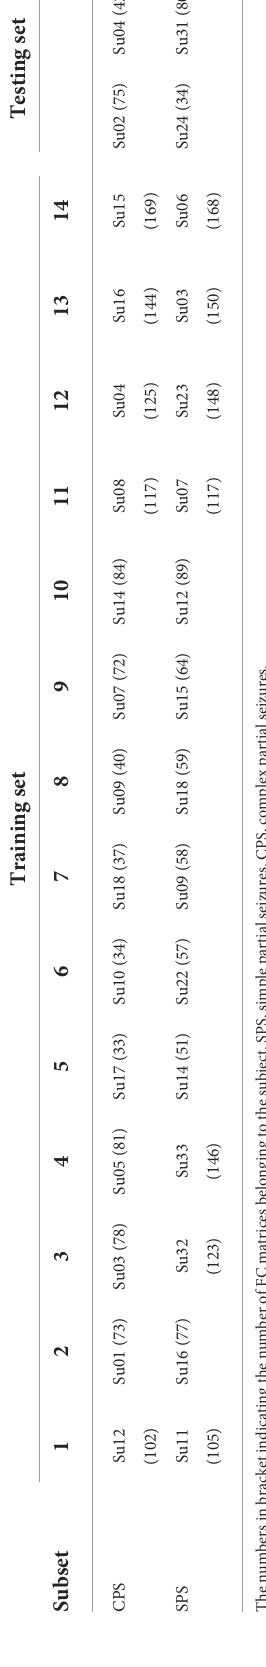
TABLE 2 Ictal semiology in the three groups of patients,the number of patients in each group having the concerning